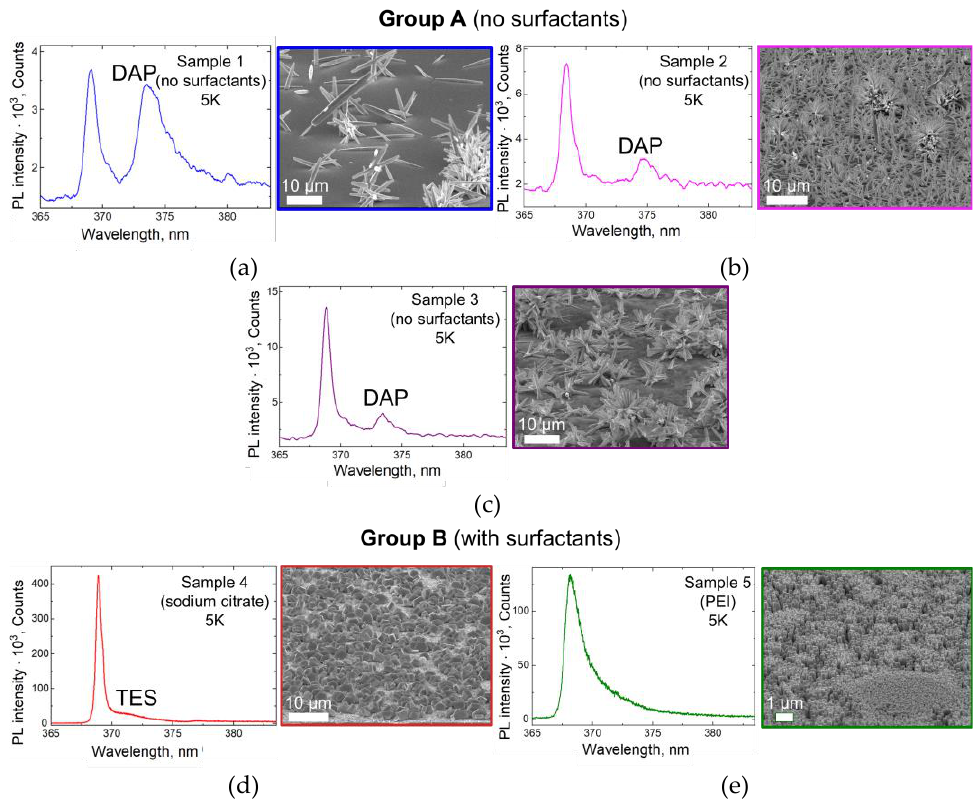
Figure 4. PL spectra taken at T = 5 K and corresponding SEM images of the samples: ( a ) Sample 1, ( b ) Sample 2, ( c ) Sample 3, ( d ) Sample 4, ( e ) Sample 5.